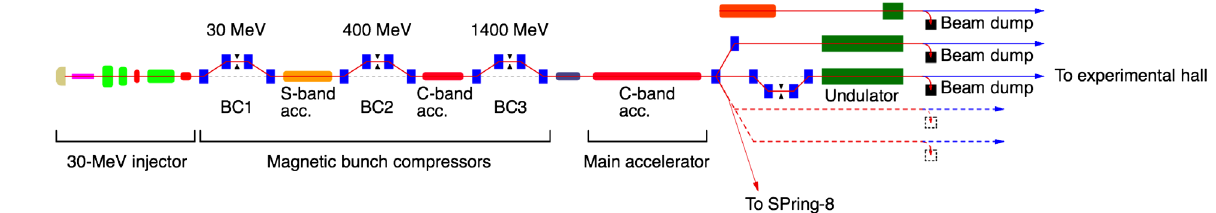
FIG. 1. Schematic view of the 8-GeV linear accelerator and undulator section of